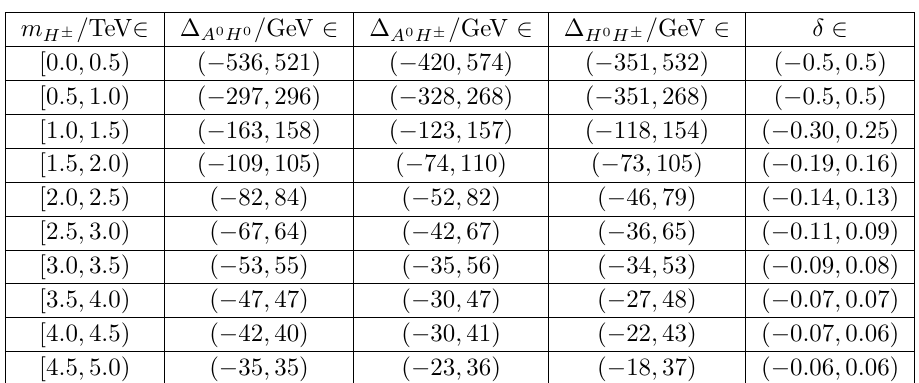
Table 1. A numerical summary of the effects of imposing the theory constraints with starting values | λ i | < 4 π . These intervals are found by carrying out a 10 8 points Monte Carlo scan with | δ | < 0 . 5 , m , m , m < 5000 GeV and − 1 . 5 < log A 0 H 0 H ±